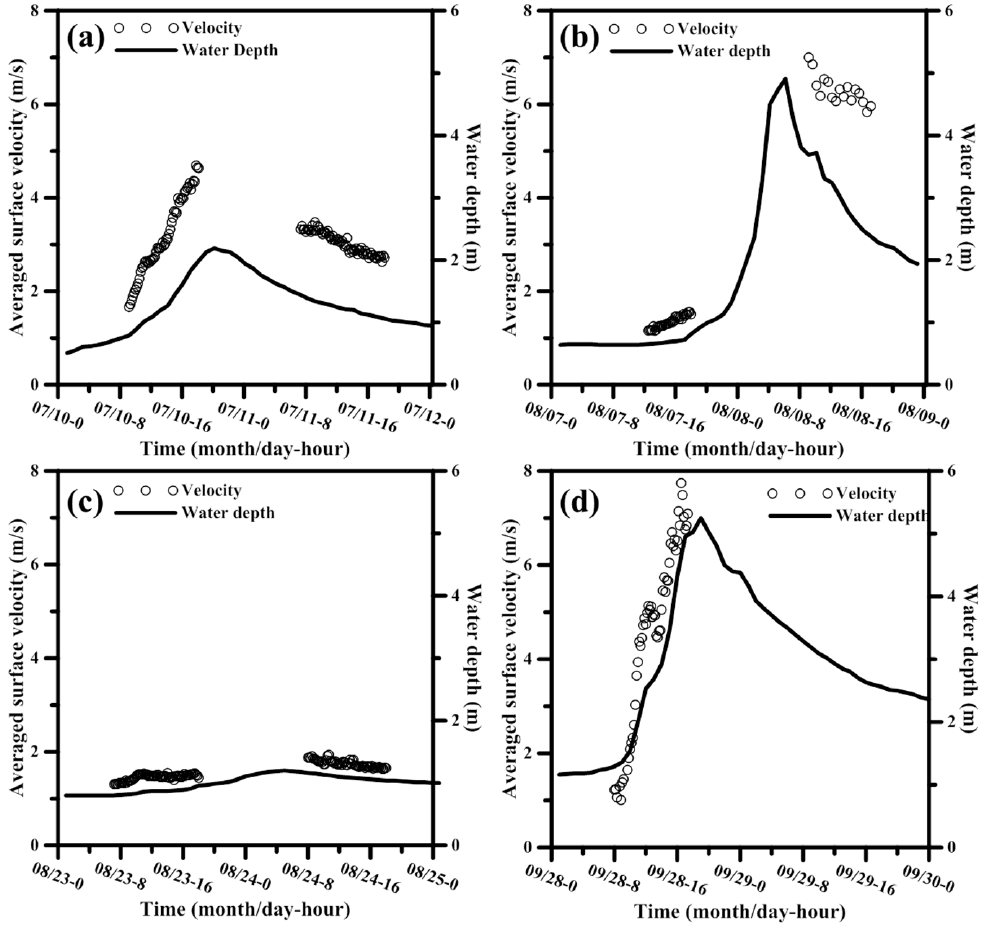
Figure 8. Time series data of self-recorded water levels and averaged surface velocities obtained by LSPIV at the Yufeng gauging station during ( a ) Typhoon Chan-Hom, ( b ) Typhoon Soudelor, ( c ) Typhoon Goni, and ( d ) Typhoon Dujuan in the year of 2015.